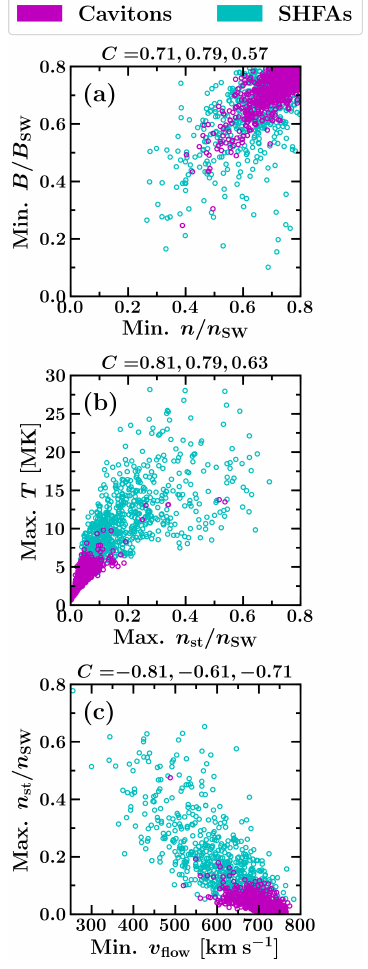
Figure 3. Scatterplots showing the correlations between different quantities for the tracked transients. The Pearson correlation coef- ficients (labelled C ) are shown above each panel for all transients, cavitons (magenta) and SHFAs (cyan), respectively. The values on the x axis are overall extreme values over tracked transients’ life- times and the values on the y axis are extreme values taken from the same time step as the values on the x